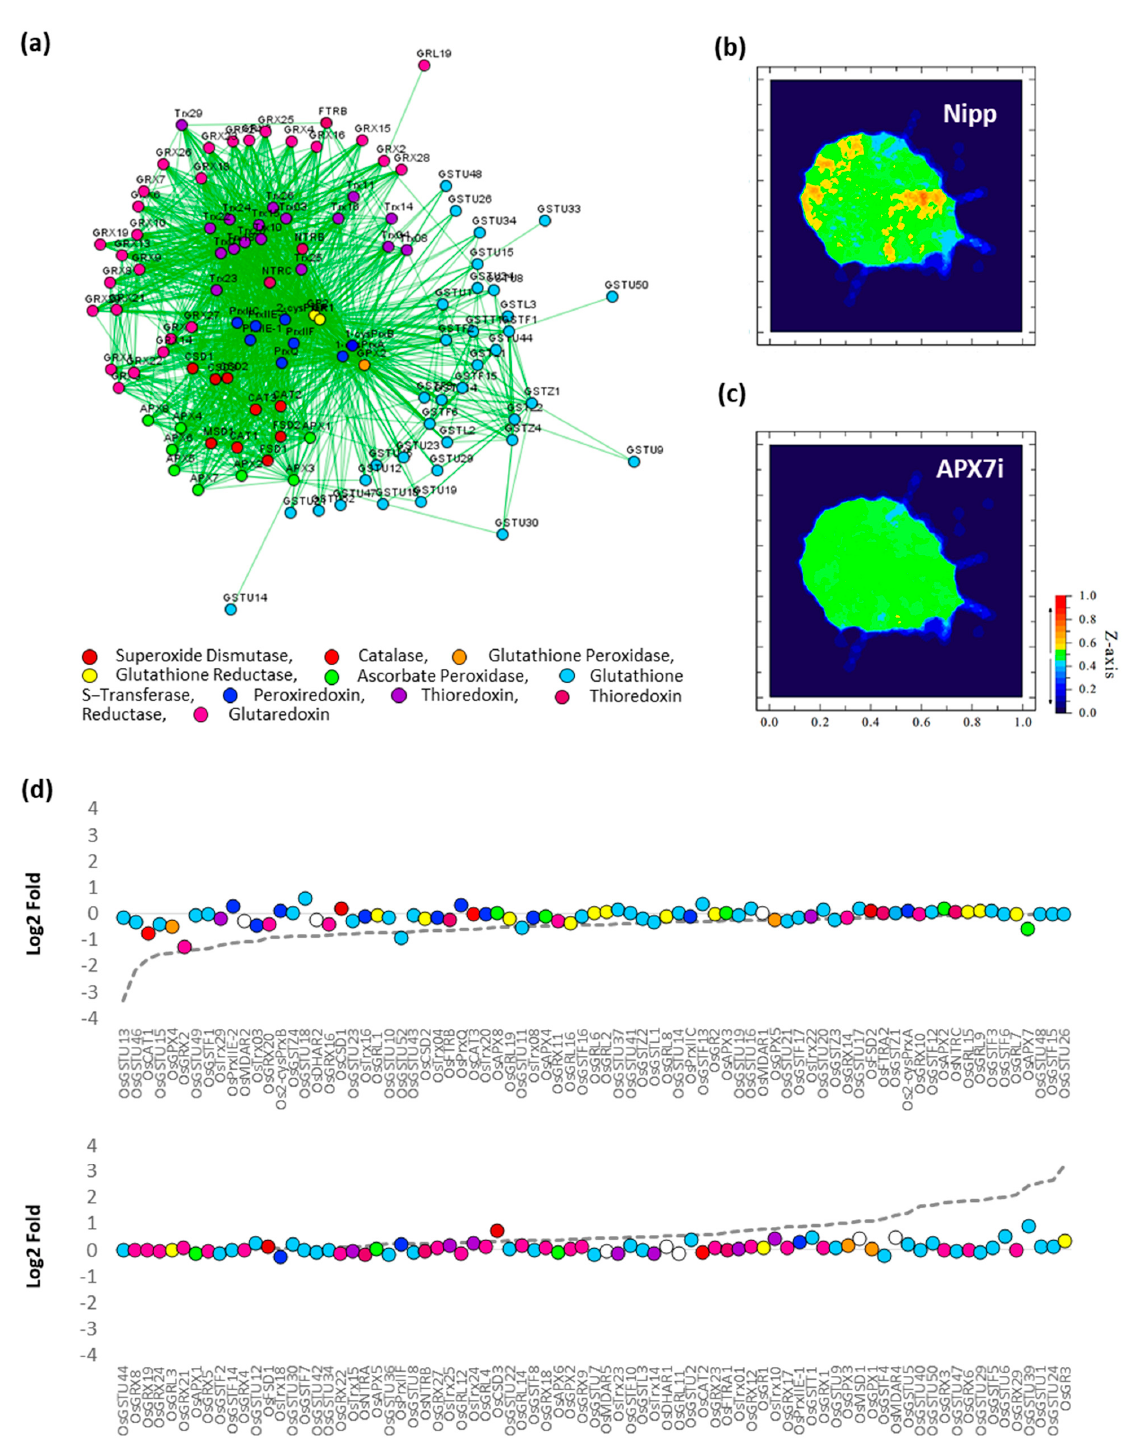
Figure 10. Effect of OsAPX7 silencing on rice antioxidant network expression in response to drought. ( a ) Antioxidant network with different families relates to antioxidant metabolism. ( b ) Heatmap demonstrating the antioxidant network expression in Nipponbare (Nipp) during drought response. ( c ) Heatmap demonstrating the antioxidant network expression in APX7i during drought response. ( d ) Relative expression of antioxidant genes in Nipp and APX7i plants in response to drought. The circles indicate gene expression in APX7i plants. The colors are in accordance with the Figure 10a legend, and white circles indicate ascorbate reductase enzymes, which are not present in the network. The dotted line indicates the gene expression in Nipp